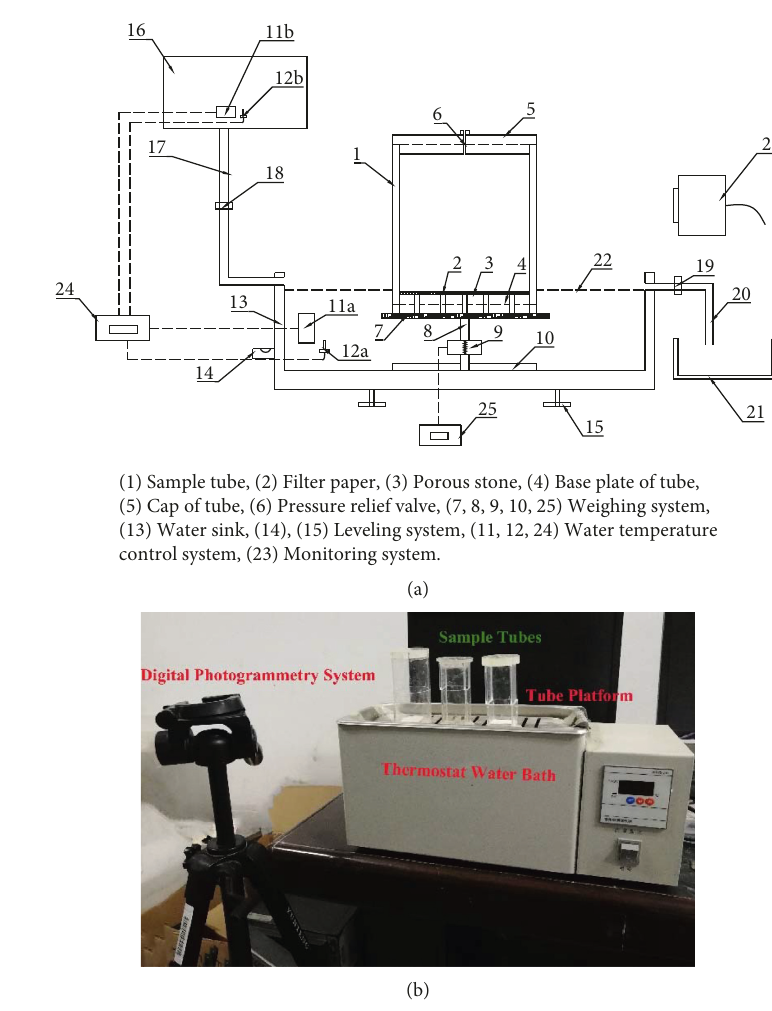
Figure 2: Diagram of the water imbibition instrument. (a) The design drawing; (b) pictures of the real